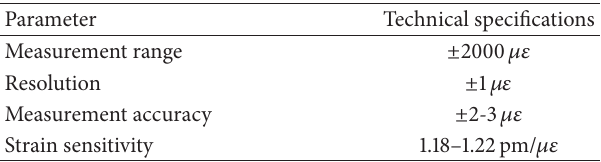
Table 7: Technical specifications of the strain